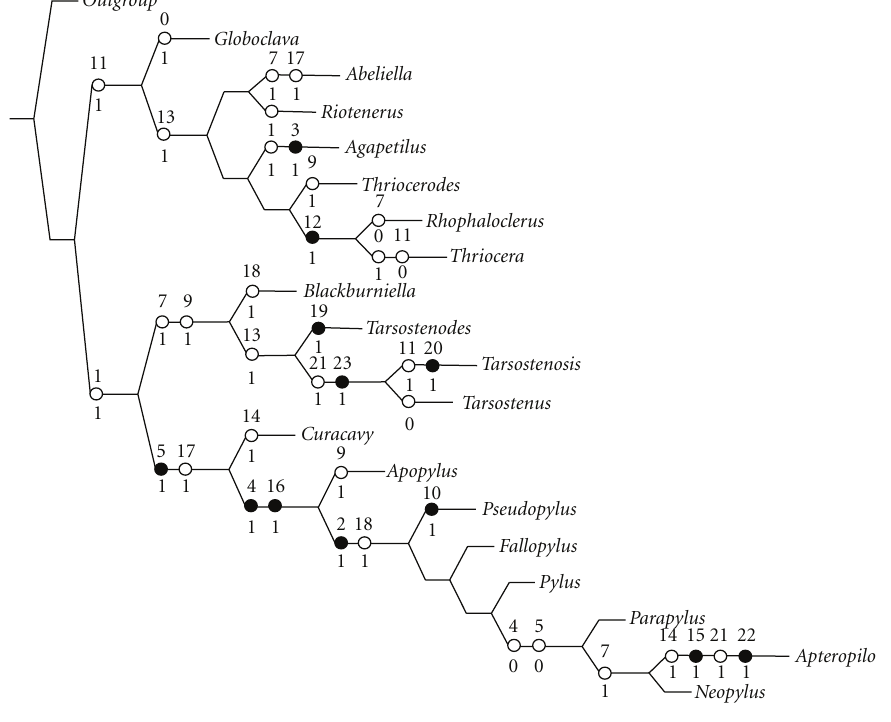
Figure 24: Phylogeny of genera of Tarsosteninae.